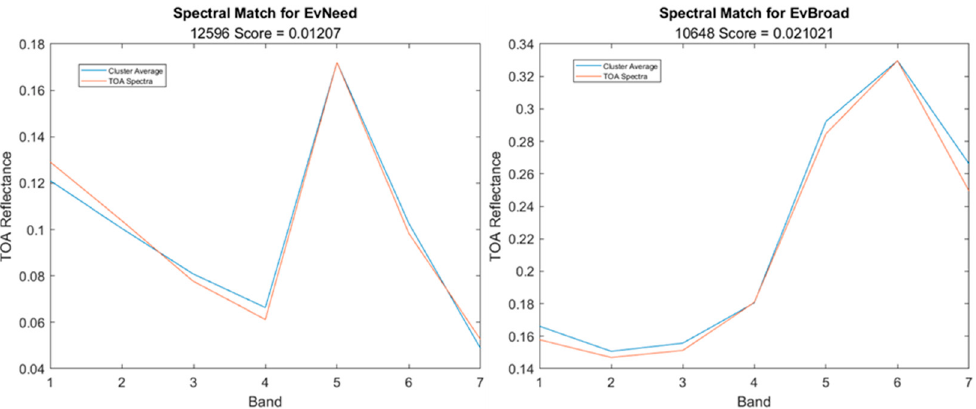
Figure 13. IGBP to Banded hyperspectral signature matched examples. Note the score in the subtitles of the plots, as it is the resulting value from Equation (4). The lower the value, the closer the spectral match of the IGBP profile to the spectral library profile. The results show the spectra are about one to two reflectance units different from their corresponding match. The number to the left of the score signifies the sample in the spectral library used to